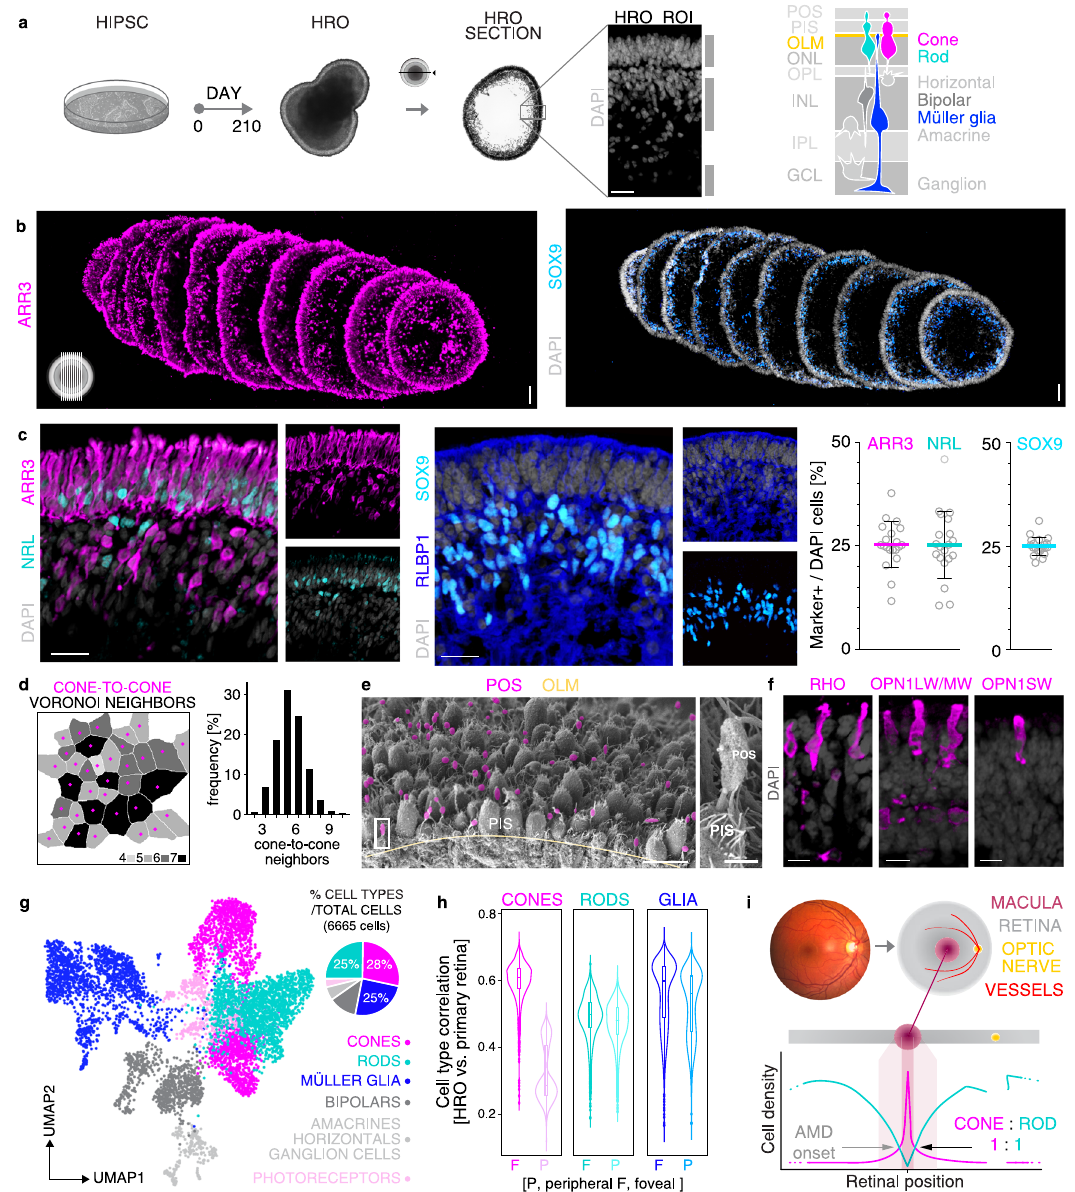
Fig. 1 | HRO system reproducing several characteristics of the human retina. a Schematic. HRO generation, retinal structure, and cell types quanti fi ed on ( b , c ) immunostained serialHRO sections:cones (ARR3);rods (NRL); MG (SOX9, RLBP1). c Graphs: circles represent individual HROs ( n ) derived from N =4 independent experiments, n ≥ 5/ N ; mean±SD over n . Part of the dataset presented in Fig. 3c, Supplementary Data 2. d Voronoi neighbor analysis: number of cone neighbors analyzed from en-face images of HRO wholemounts immunostained for cone (ARR3), photoreceptor (RCVRN), and Müller glia (SLC1A3+RLBP1) markers (Sup- plementary Fig. 3a – e, k; N =1; n =8; mean±SD over n ; 3 ROIs averaged/ n ). e Scan- ning electron microscopy of HRO indicated the formation of photoreceptor inner (PIS)and outer (POS) segments ( N =1, n =6). f Rod(RHO) and cone (OPN1LW/MW, OPN1SW) opsin immunostaining on HRO sections ( N =1; n =9). g HRO single-cell RNA-seq analysis: dotplot shows cell clusters after Louvain cluster detection in a UMAP embedding.Piechart:relative abundance of majorcelltypes inanindividual HRO. Dotplot/piechart: pseudocolored for cell types as indicated. Photoreceptors